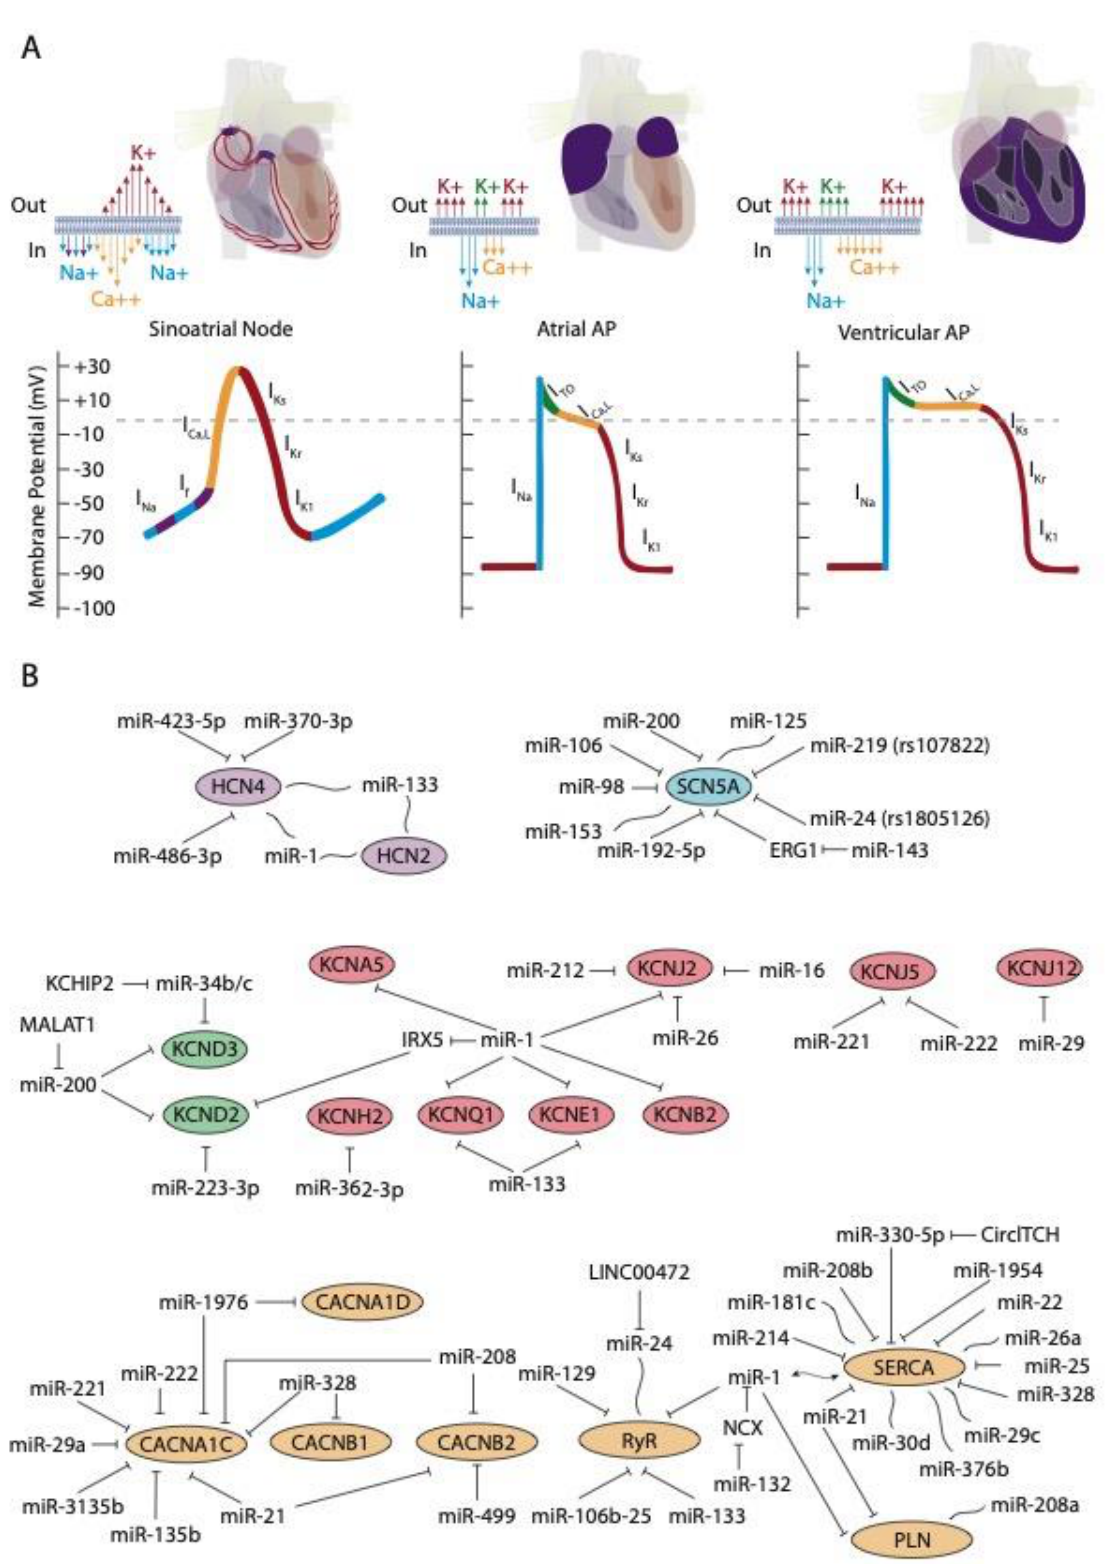
Figure 1. ( A ) Graphical representation of the cardiac action potential in the sinoatrial node (and also the atrioventricular node) and in contractile working myocardium of the atrial and ventricular chambers. ( B ) Schematic representation of the functional roles ncRNAs within the cardiac action potential regulation (— direct; ∼ indirect). Colors represent different phases of the cardiac action potential and related genes.